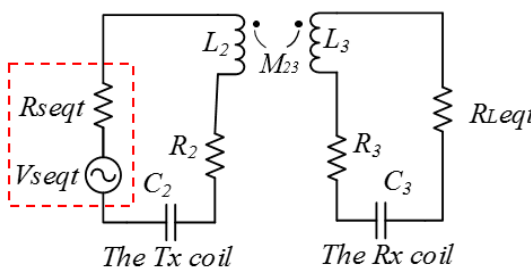
Figure 4. Equivalent simplified circuit diagram of the four ‐ coil WPT system.